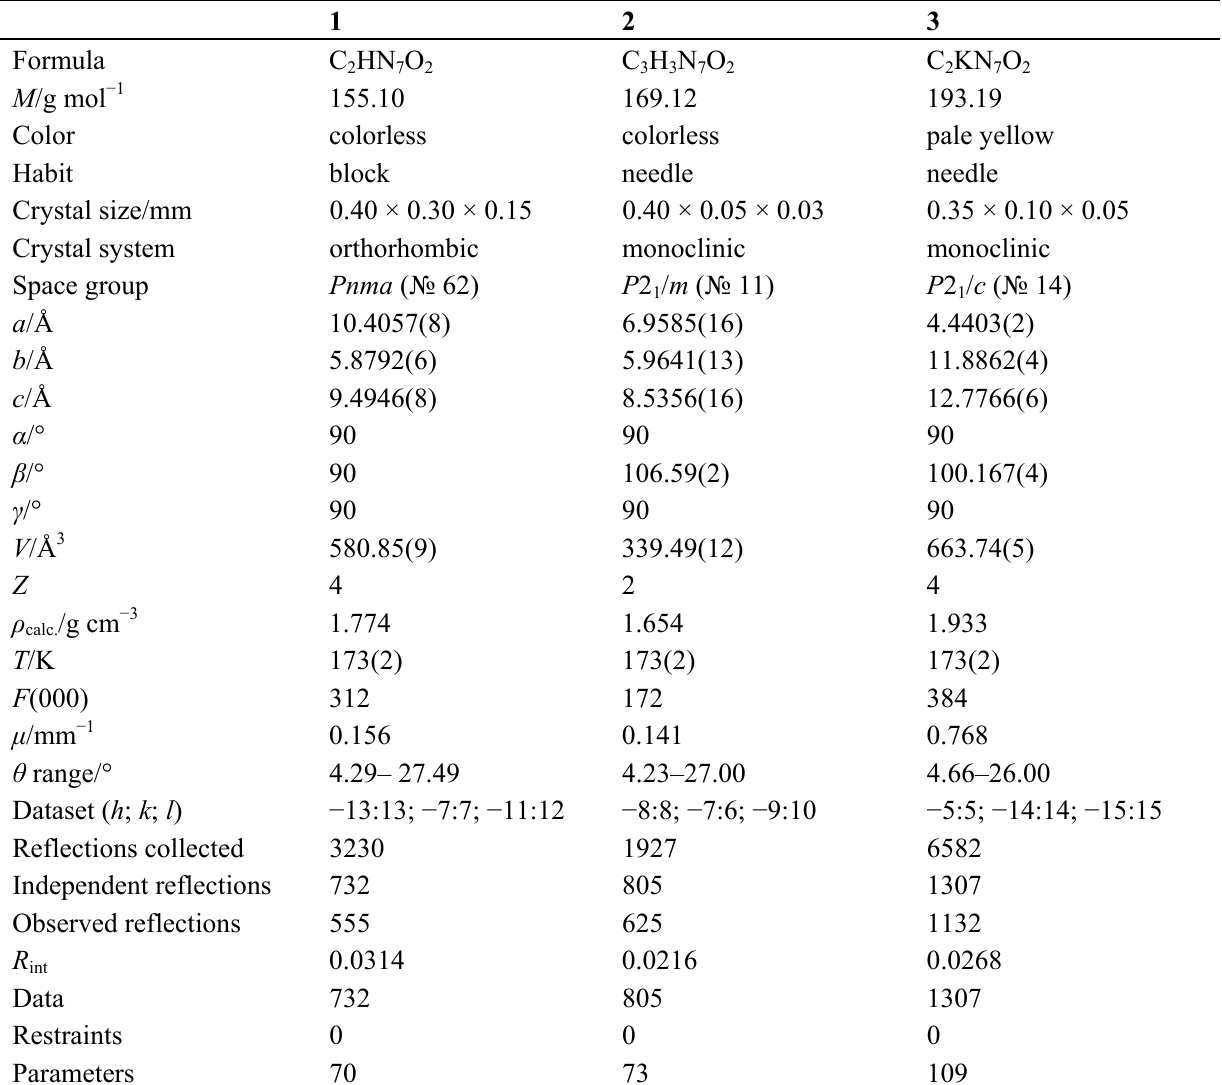
Table 1. Crystallographic data for 1 – 3